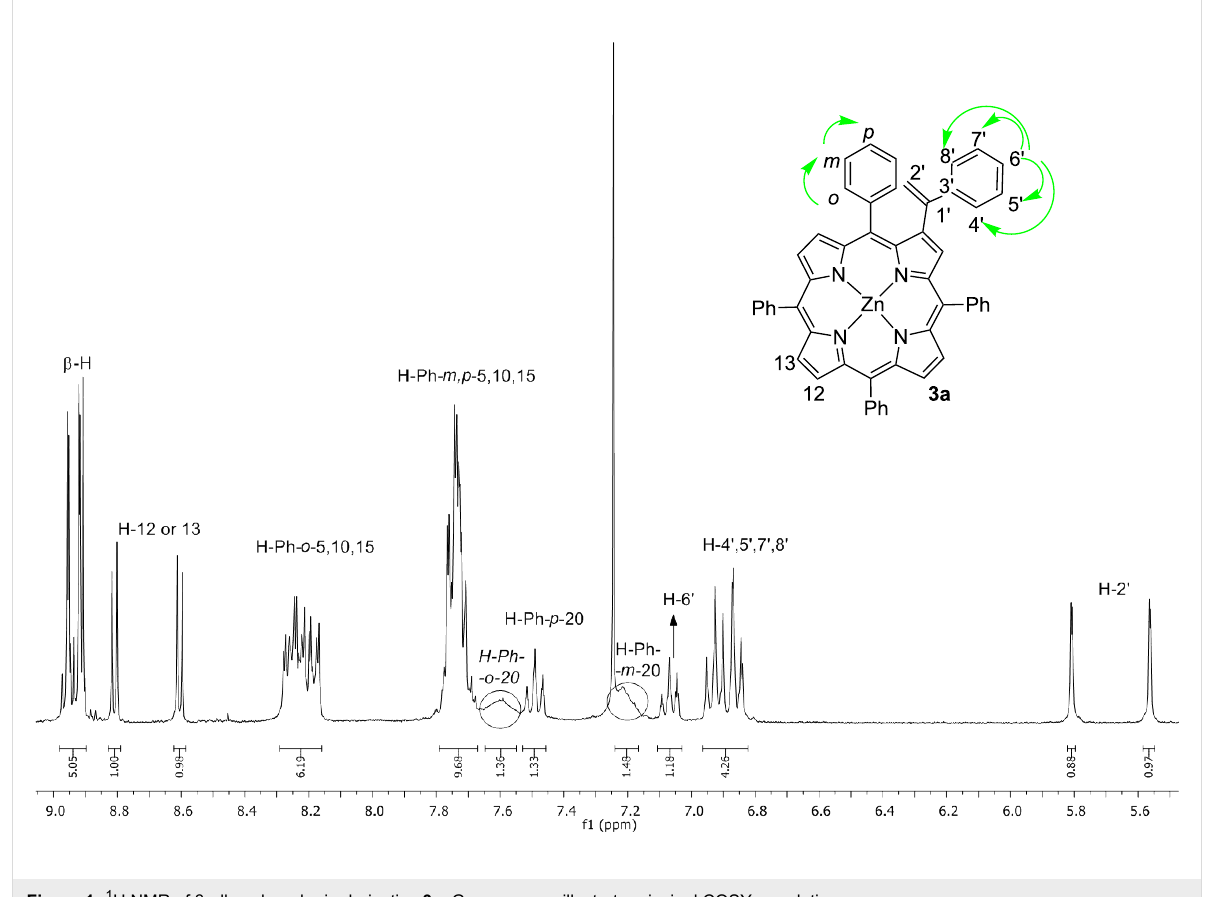
Figure 1: 1 H NMR of β -alkenylporphyrin derivative 3a . Green arrows illustrate principal COSY